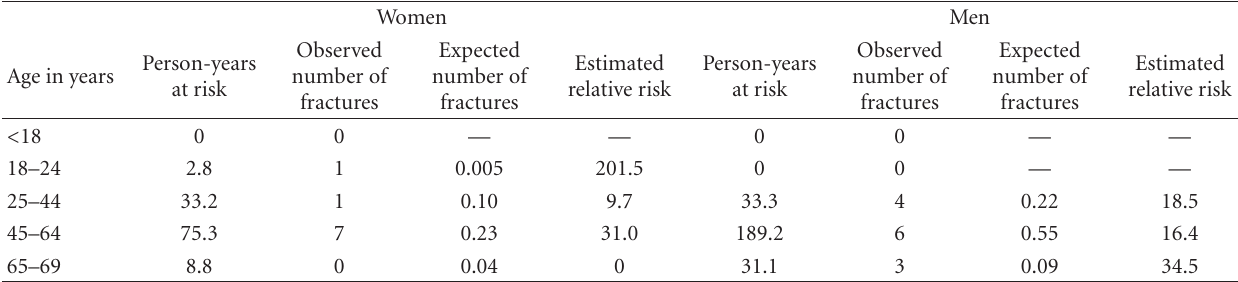
Table 6: Age- and gender-specific fracture incidence rates in liver transplant recipients.